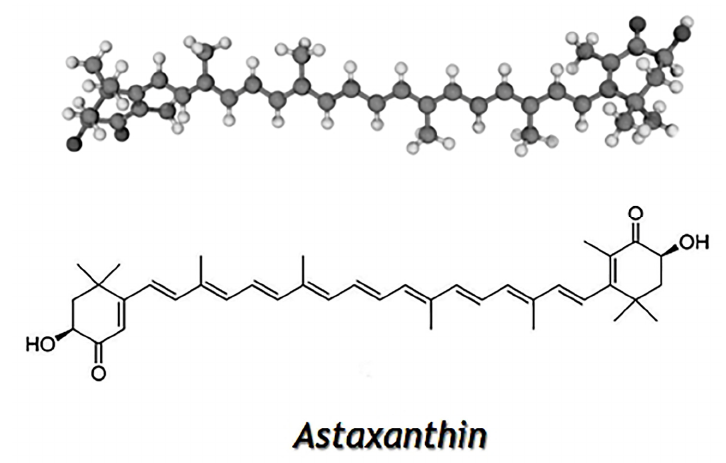
Figure 2. Chemical structure of